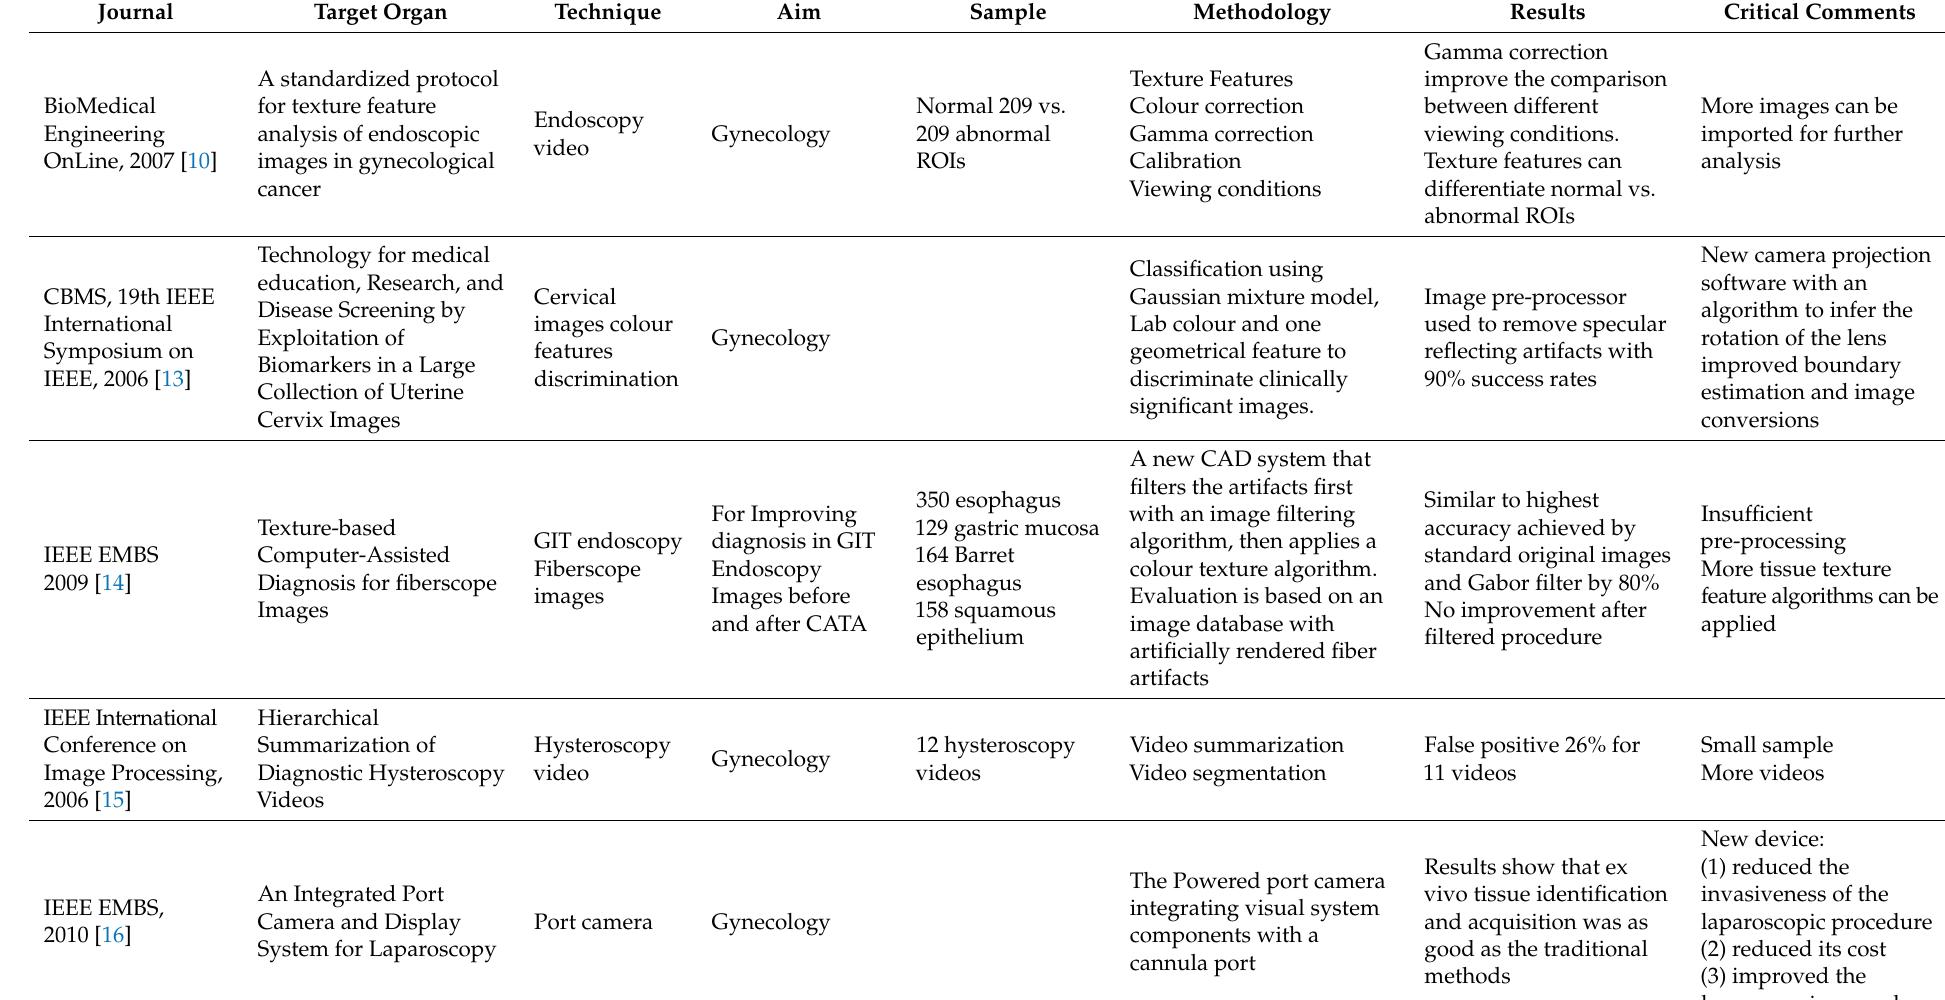
Table 4. Technical papers for image processing